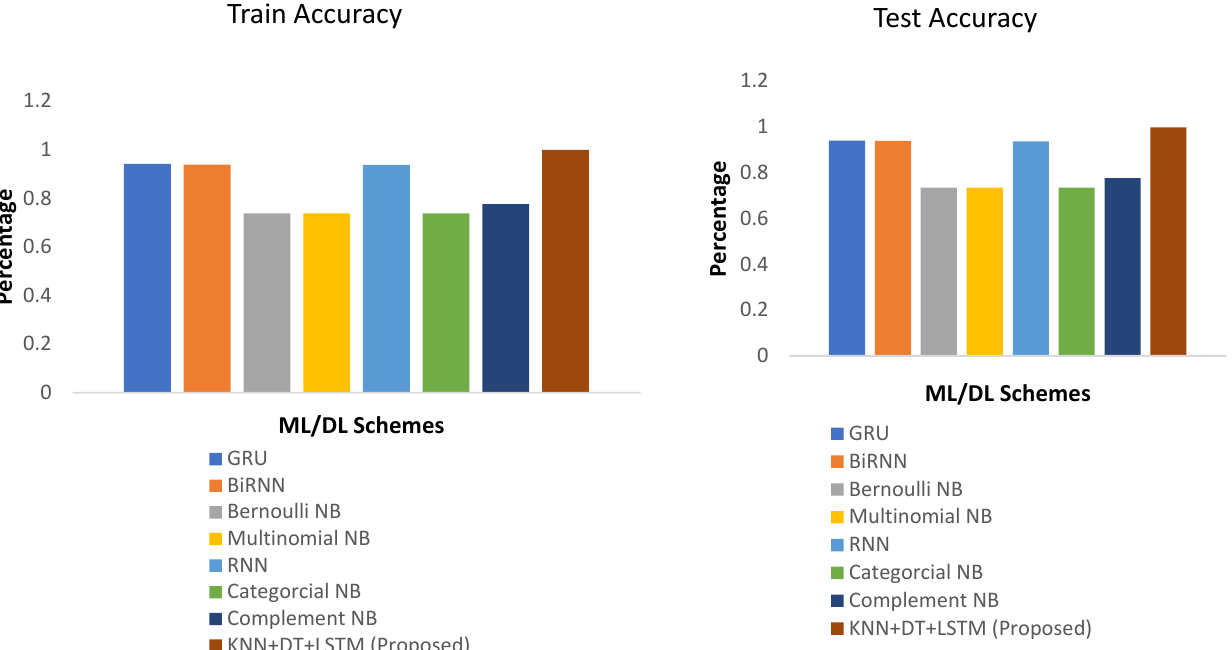
Figure 12. Training and Test Accuracy on Different Models.